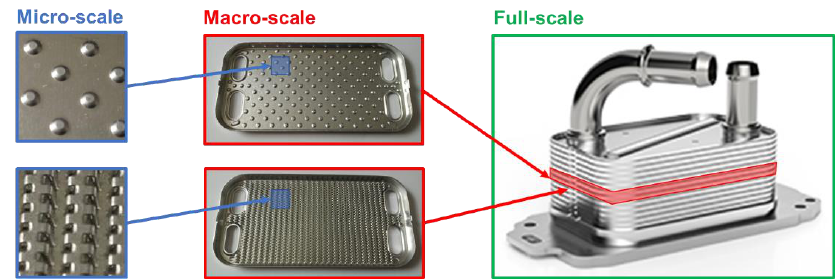
Figure 1. Overview of the characteristic scales of the problem: Micro-scale, macro-scale and